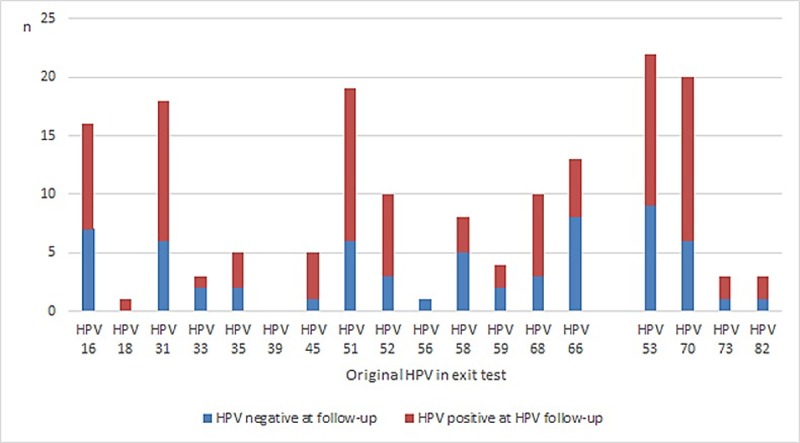
Comparison of original HPV present in the exit test, amongst follow-up tests negatives or positives.